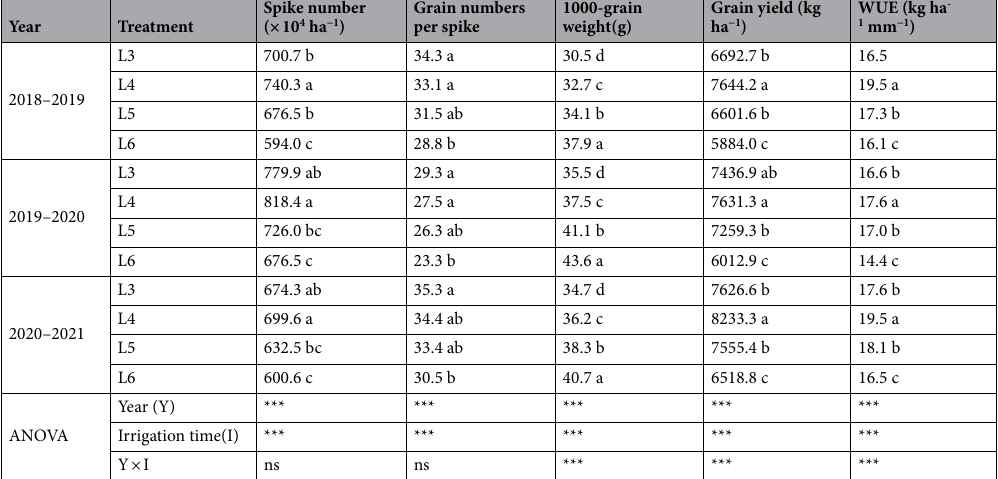
Table 3. Effects of irrigation time on grain yield, yield components and water use efficiency in winter wheat. Different letters indicate significant difference in treatments at P < 0.05 level. Y, year; I, irrigation time. *** indicate significant effects at P < 0.001, respectively; ns indicates no significant effect. Values are means ± standard error ( n = 3). ANOVA, analysis of variance; WUE, water use